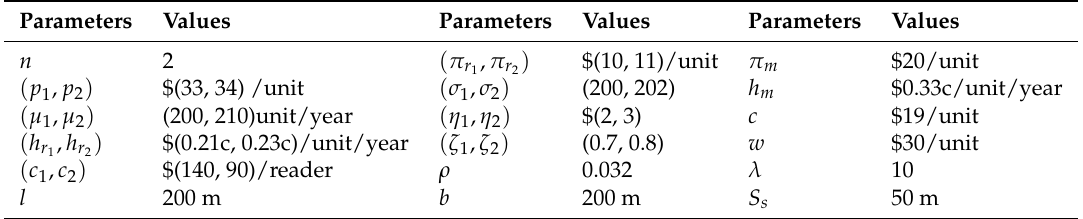
Table 3. Input values of the parameters for Example 1.